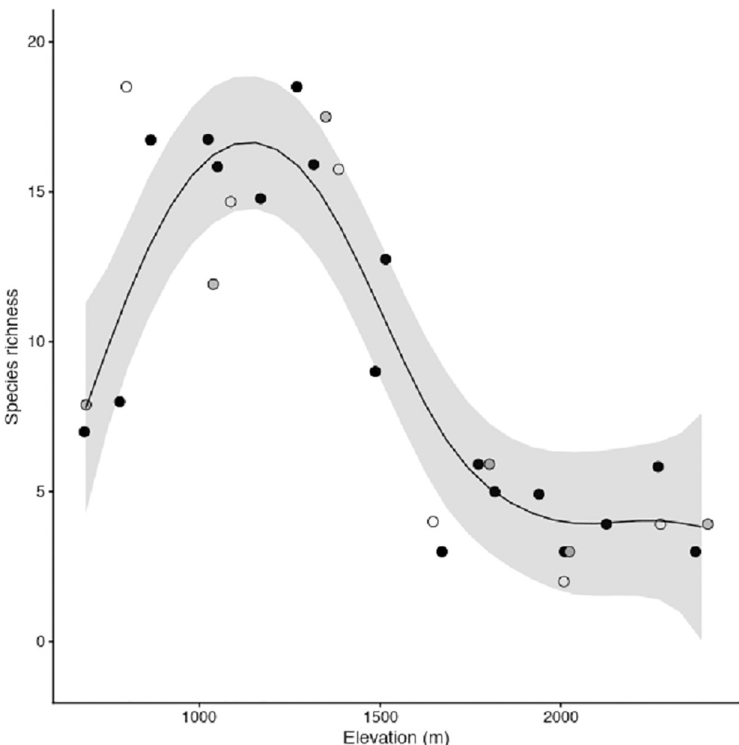
Fig 2. Relationship between first-order jackknife estimates of ant species richness (see Table 1) and elevation in dry grasslands of a Mediterranean range in central Spain. Curve and 95% IC from GAM with Gaussian errors fit to the Guadarrama 2014 survey (black circles). Richness estimates for the surveys in Guadarrama 2015 (grey circles) and Serrota 2015 (open circles) were superimposed. Elevation values were slightly jittered to avoid overlap among some